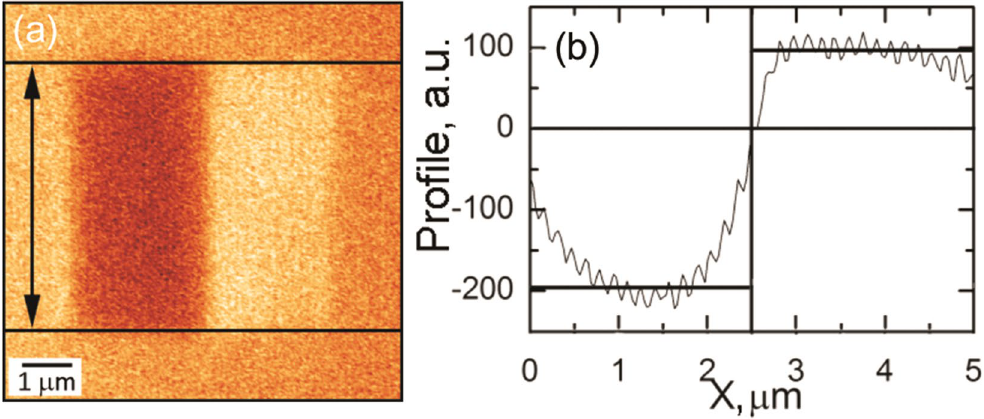
Figure 2. ( a ) Typical PFM image of the polarized area recorded by “continuous” scanning and ( b ) averaged PFM signal across the poled region.